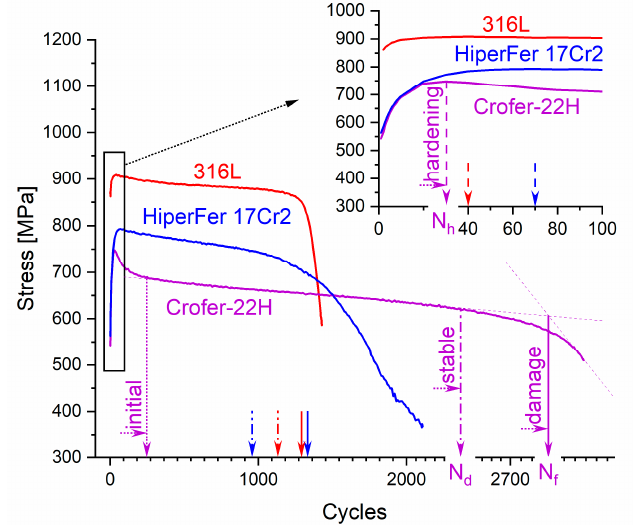
Figure 18. Comparison of thermomechanical fatigue curves of 316L [18], Crofer22 H, and HiperFer 17Cr2 (100% out-of-phase cycles (i.e. ε mech = −ε th .), Δ T = 50–650 °C, dT/dt = 10 Ks − 1 , t h = 0 at T min and T max ) [18].